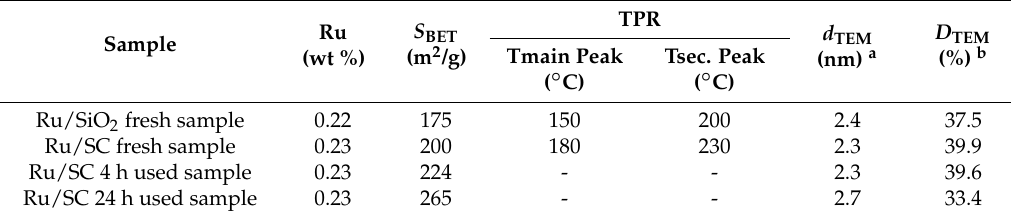
Table 4. Results of characterization of ruthenium catalysts before and after reaction. a d TEM (nm) is the average particle diameter from transmission electron microscopy (TEM) images; b D TEM (%) is the metal dispersion. TPR: temperature ‐ programmed